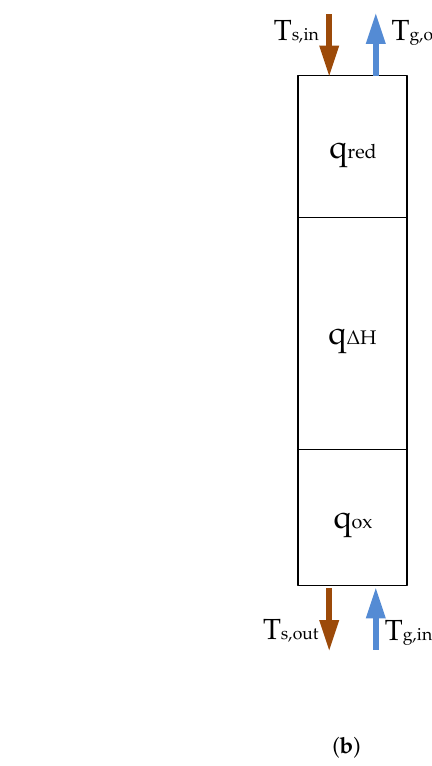
Figure 2. ( a ) 1D geometry of the moving bed reactor, including the boundary conditions at the inlet (in) or outlet (out) of the gas (g) and solid (s) flows. ( b ) Schematic description of the three heat transfer sections: sensible thermal energy of the reduced phase ( q red ), thermochemical energy due to reaction enthalpy ( q ∆ H ), and sensible thermal energy of the oxidized phase ( q ox